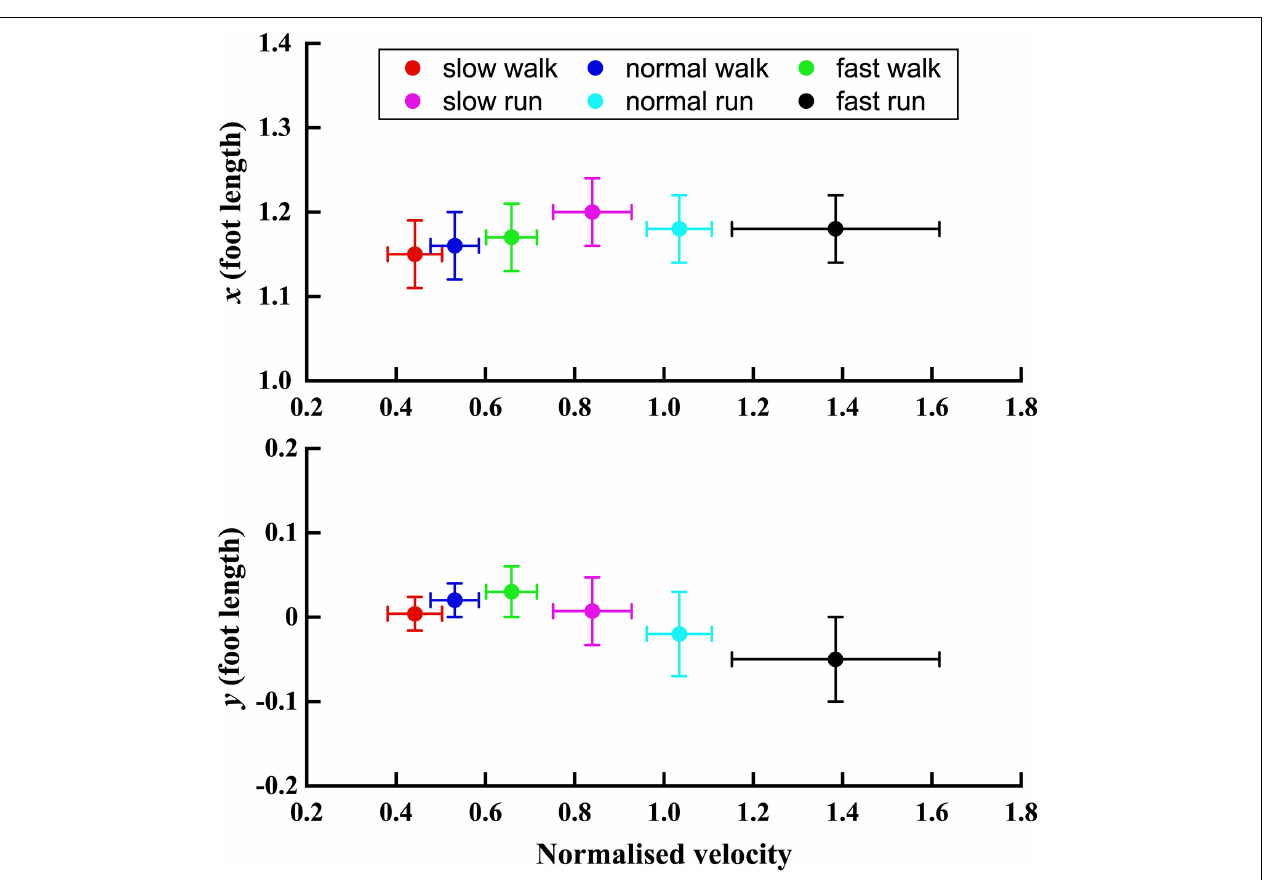
The value of mean ± SEM for all the trials across all the subjects were depicted. Different letters mean that the variable in a column differs significantly with each other (p < 0.05).